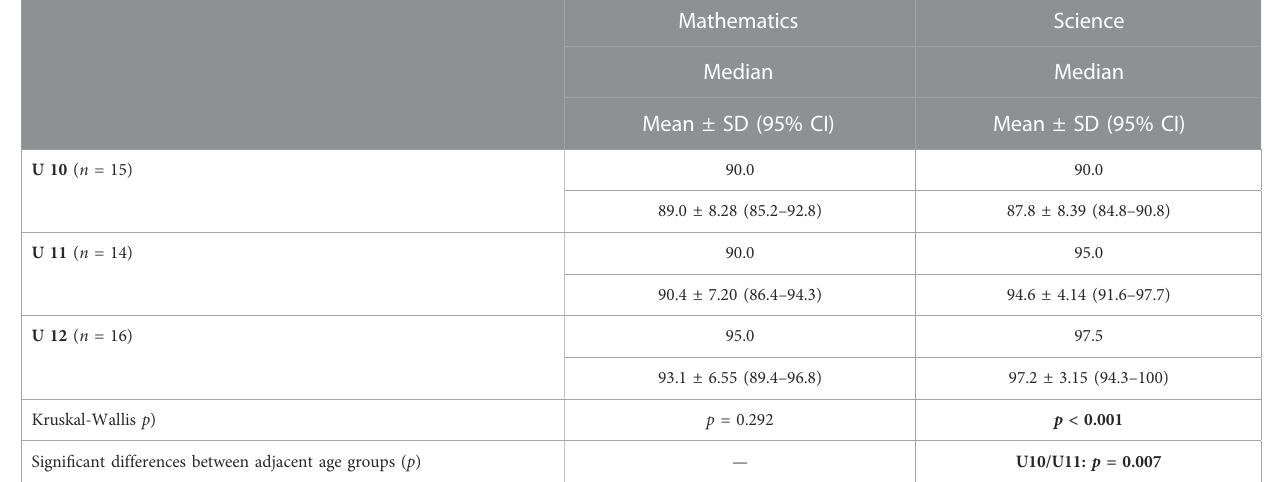
TABLE 7 Academic performance in relation to age groups.